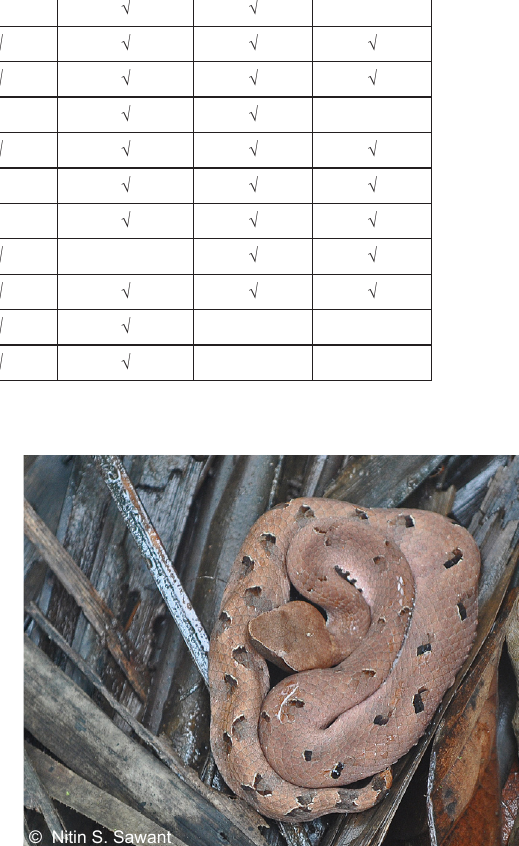
South Indian subtropical savannah woodland